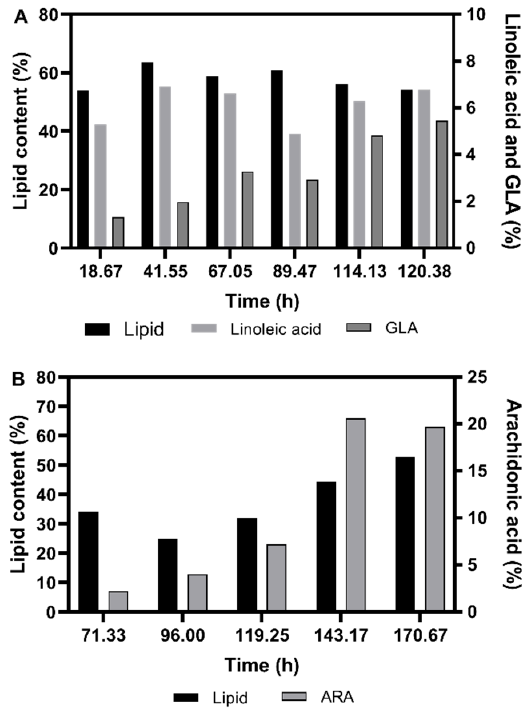
Figure 4. (A) Total lipid content (% wt of dry cell weight), linoleic acid, and GLA (% wt of total lipid weight) for M. circinelloides , and ( B ) total lipid content (% wt of dry cell weight) and arachidonic acid (ARA) content (% wt of total lipid weight) for M. alpina , grown on animal fat rest materials in shake flasks.